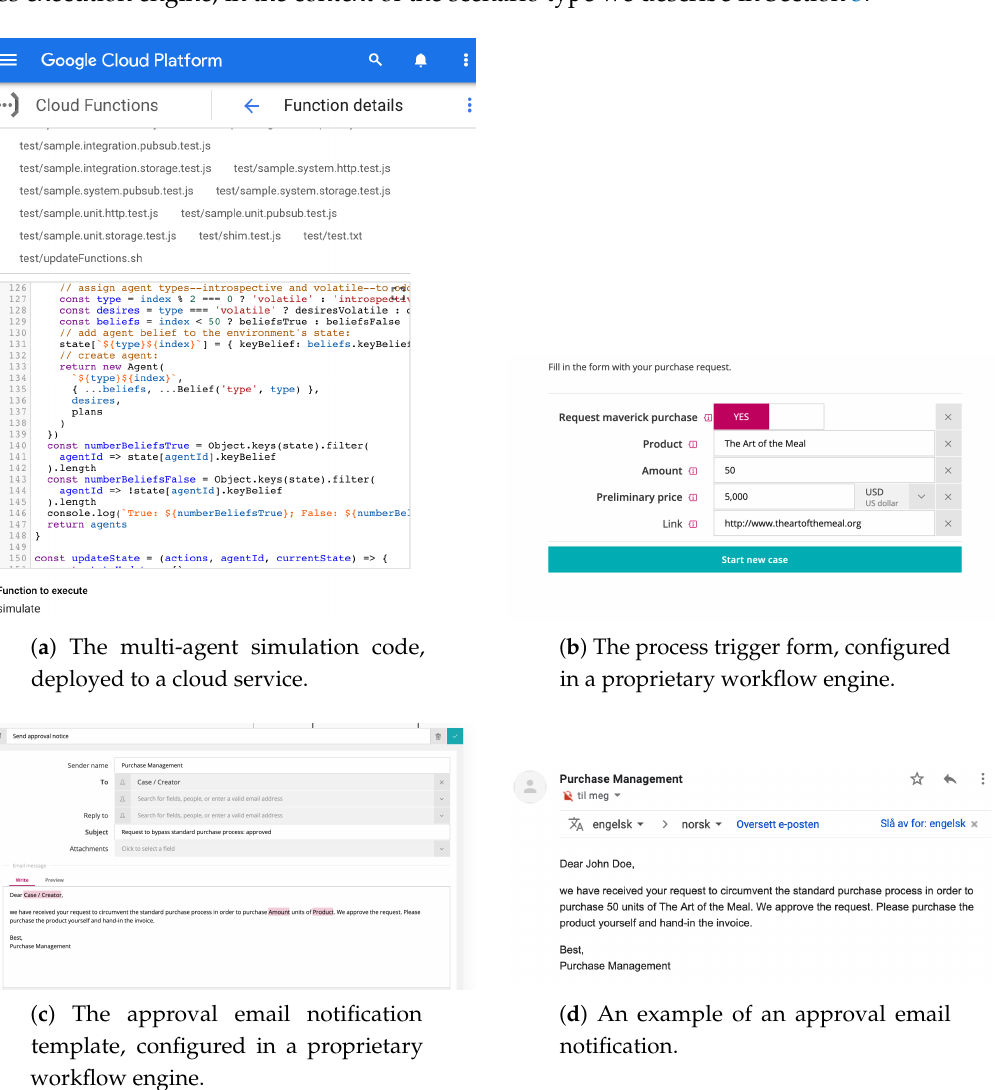
Figure 8. Example configurations, created with proprietary cloud